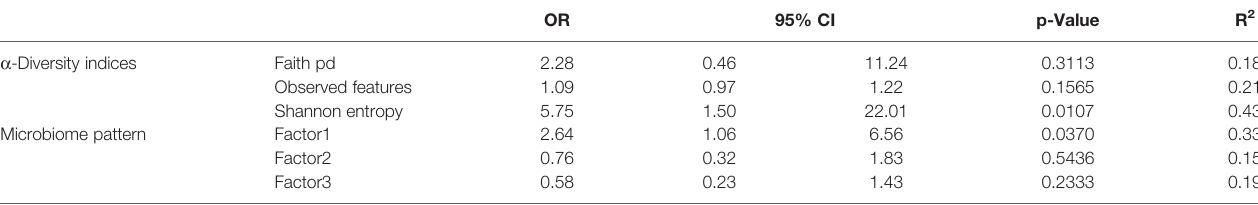
TABLE 5 | Odds ratios for the estimated contribution of each a -diversity index and microbiome pattern to the probability of preserving IgG antibodies at follow-up. OR